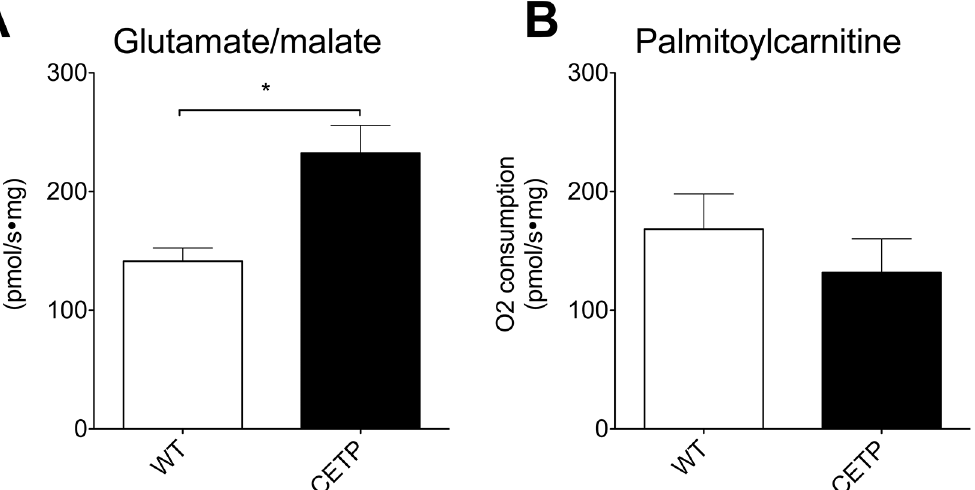
Fig 4. CETP expression increases mitochondrial oxidation in female mice. (A) Oxygen consumption in isolated muscle fibers treated with glutamate/ malate mixture to measure total substrate oxidation. (B) Oxygen consumption in isolated muscle fibers treated with palmitoylcarnitine to measure fatty acid oxidation. Data represent mean ± SEM. n = 8 – 14 muscle fibers per group. * indicates p < 0.05 by unpaired t-test.